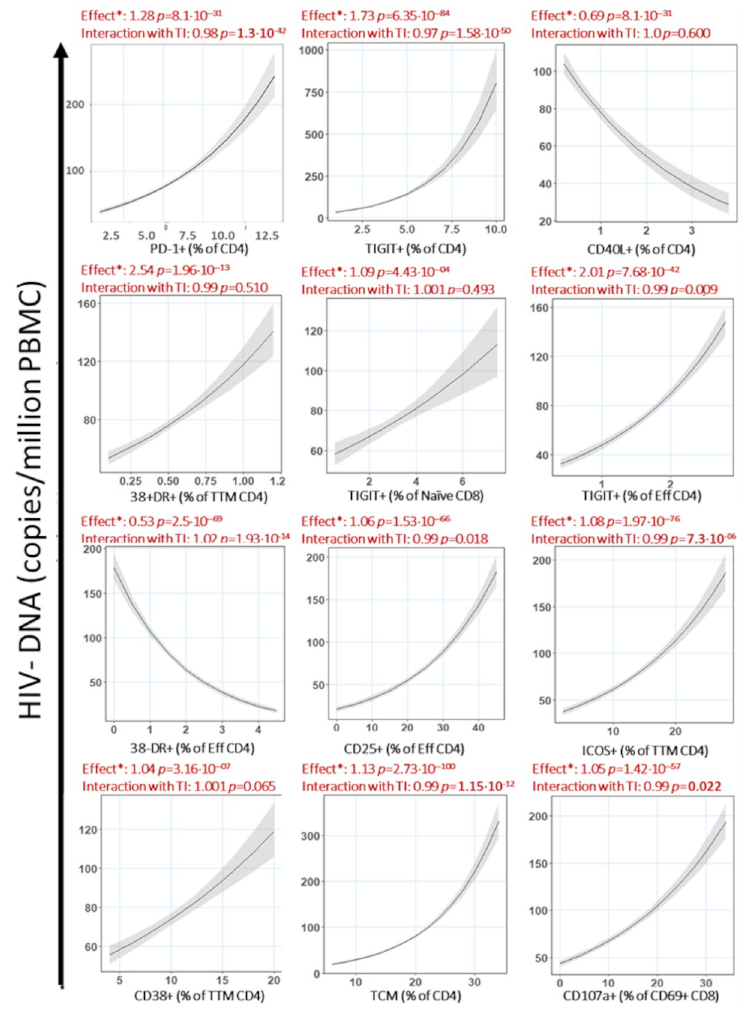
Fig 2. Predictors of HIV-1 DNA reservoir associate with HIV-1 DNA reservoir and interact with age at Treatment initiation (TI). Predictors identified by penalized regression were plotted against the predicted outcome (HIV-DNA) based on the multivariable Poisson regression model after adjusting for baseline CD4, baseline viral load, age at the reservoir measurement and age at ART. � : effect of the association between the parameter and the reservoir. By increasing one unit the predictor a X% increased of the reservoir is predicted. A value of effect above 1 indicates a positive contribution while a value between 0 and 1 indicates a negative contribution. Interaction of immune variable plotted with time of treatment initiation (TI) is also indicated on